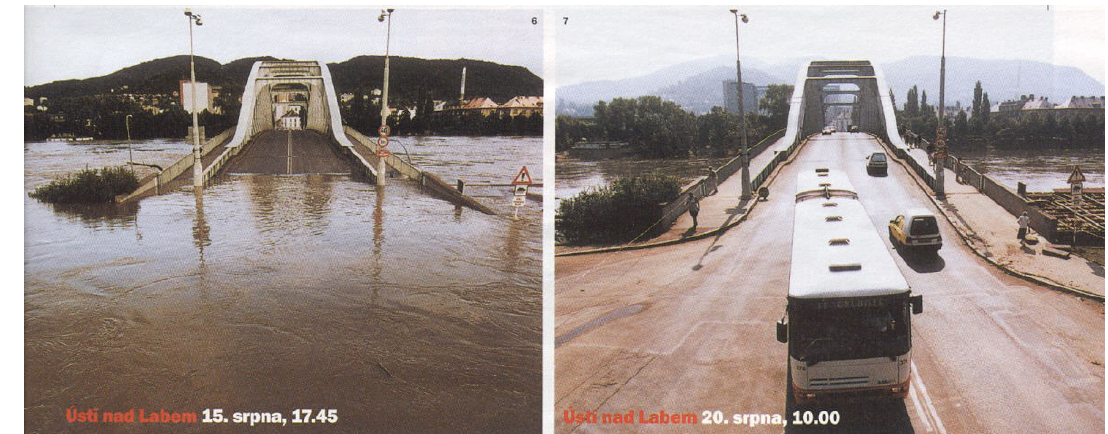
Figure 1. Re-opening of the bridge in Ústí nad Labem five days after